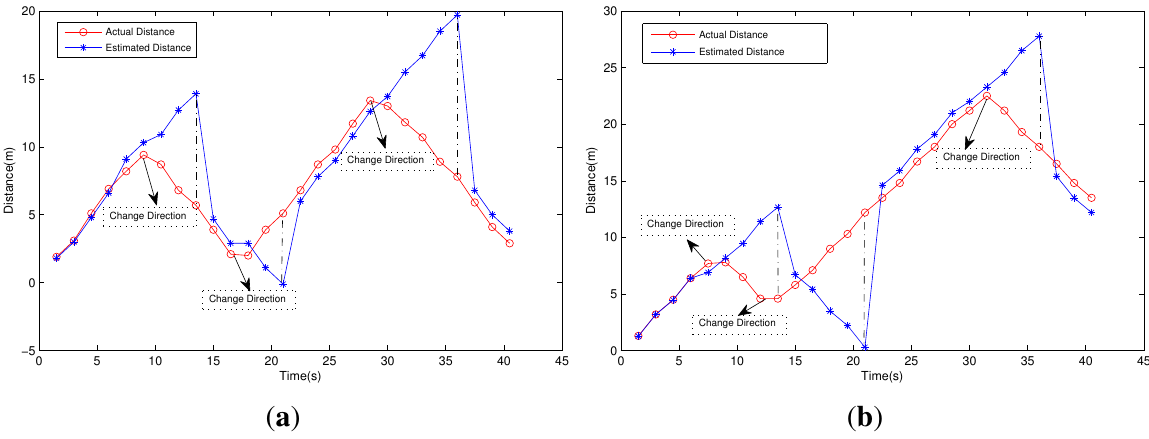
Figure 13. The relationship between distance and time: ( a ) Participant 1; ( b ) Participant